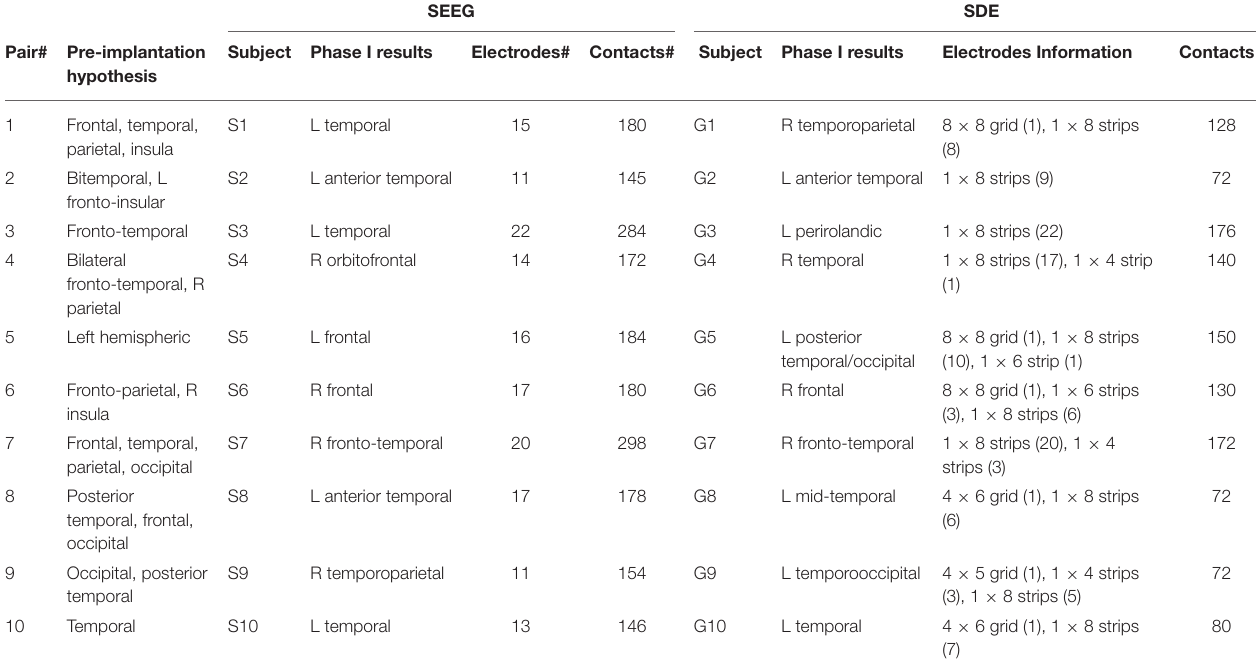
TABLE 1 | Subject Clinical Details. Each SEEG implant was matched with a SDE implant with a similar seizure semiology, seizure onset, and seizure spread hypothesis (based on Phase I evaluation).